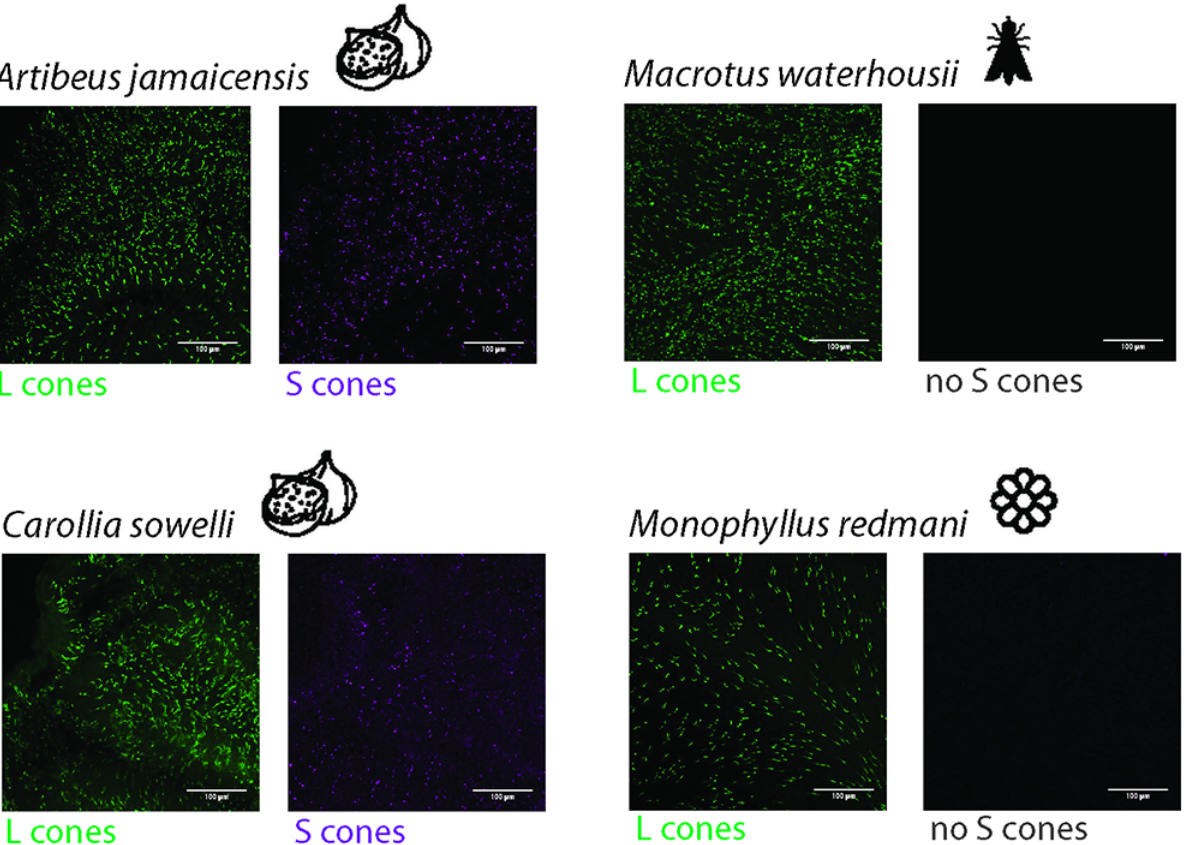
Figure 3 – Color vision diversity in Phyllostomids (adapted from Sadier et al. , 2018). Cones are shown on flat-mounted retinas in four different bat species representative of the cone diversity in Phyllostomids. To visualize L opsin (green) and S opsin (magenta), flat-mounted retinas were probed with two antibodies against L and S opsins. L opsin expressing cones were found in all bats, while S opsins were only seen in fruit visiting Carollia and Artibeus species, indicating cone type and diversity vary between species occupying different dietary niches. Diet is indicated with a